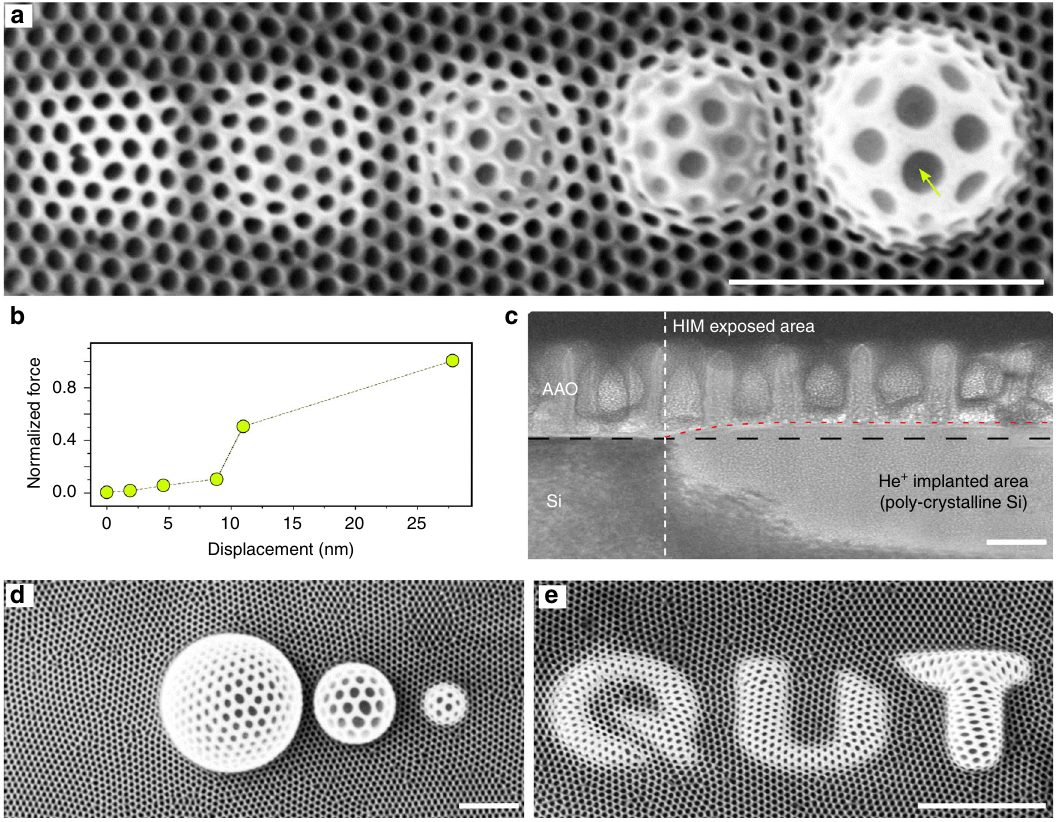
Fig. 6 Superplastic shaping of AAO. a Ion-induced damages in Si produced patterns on the surface, which forcefully stretched and bended the superstate am-AAO thin fi lm during the irradiation. am-AAO elastically/plastically responded to the morphological changes of the substrate in both nanometer and micrometer scales. The irradiation fl uence from left to right: 1 × 10 16 , 5 × 10 16 , 1.0 × 10 17 , 5.0 × 10 17 , and 1.00 × 10 18 ions cm − 2 . b Inelastic deformation of am-AAO in response to the imposed forces from the substrate. c TEM cross-section of the implanted area at the high- fl ux regime (and the comparison to non-irradiated area). The volume increase due to amorphization of Si substrate ( fl uence: 1 × 10 16 ions cm − 2 ) is evident by the difference in contrast between the two regions. The scale bar is 100 nm in the TEM image. d shows the possible extend of helium ion irradiated am-AAO superplastic stretching with 1.00 × 10 18 ions cm − 2 at 3 different scales. e Shows that different nanoscale patterns can be produced by He + implantation in the substrate at the high- fl ux regime. The scale bar is 1 µ m in HIM